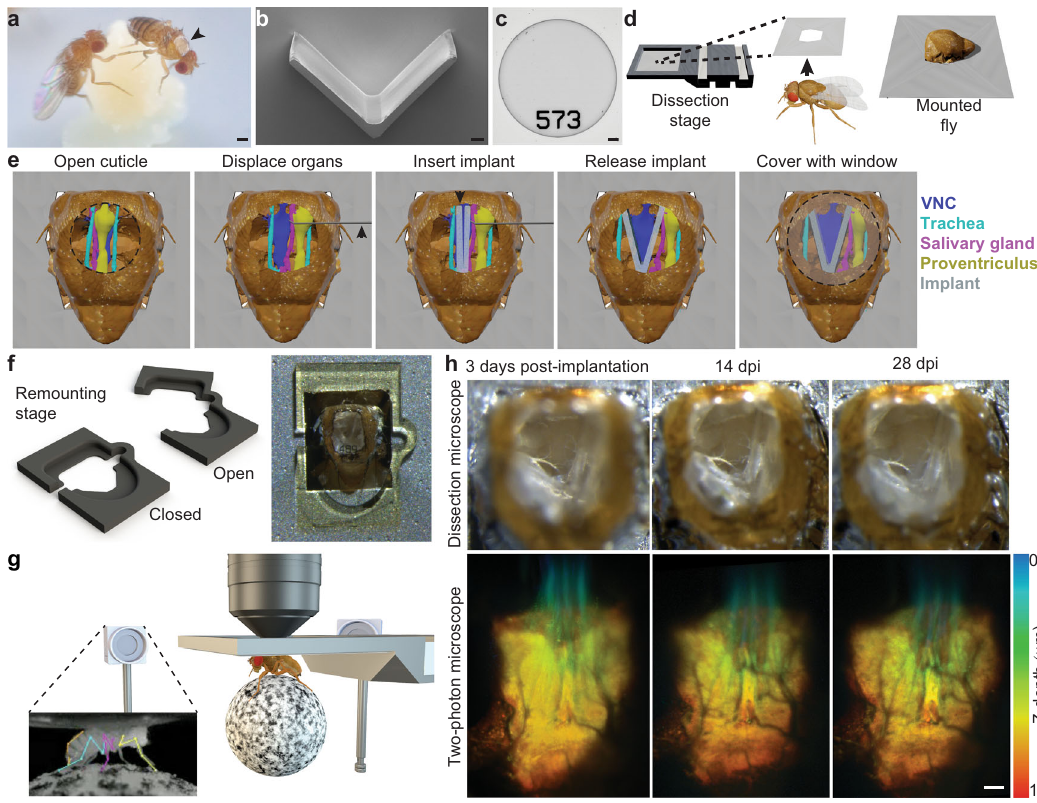
Fig. 1 | Long-term recording technologies, work fl ow, and experimental vali- dation. a Implanted adult fl ies can be raised in complex environments. An implantedanimal---seedorsalthoracicwindow(blackarrow)---interactswithanon- implanted animal. Scale bar is 0.5mm. b A mechanically compliant, transparent implant microfabricated from Ostemer 220. Scale bar is 50 μ m. c A numbered, transparent thoracic window microfabricated from SU-8. Scale bar is 50 μ m. d For implantation, an animalis mounted,thorax fi rst, intoa holein asteelshimwithin a dissection stage. e A multi-step dissection permits long-term optical access to the ventralnervecord(VNC). left Aholeiscutintothedorsalthoraciccuticle,revealing the proventriculus (yellow),trachea (cyan),and salivary gland (magenta)overlying the ventral nerve cord (VNC, dark blue). The indirect fl ight muscles (IFMs) were degraded by tissue-speci fi c expression of Reaper ( Act88F:Rpr ) 23 . Then, using a custom-designed manipulator arm, thoracic organs are displaced, revealing the VNC. middle Next, the implant is placed within this thoracic hole in a narrow, mechanically closed con fi guration. right The arm is removed and the implant